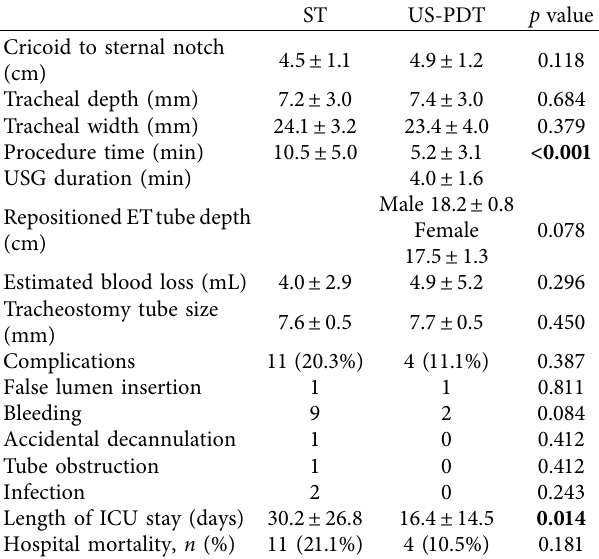
Table 2: Procedure details and related complications by